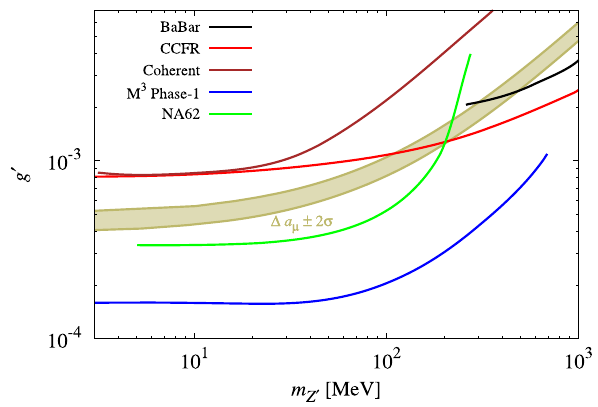
Fig. 3 The colored band represents the regions of parameter space in which an L μ − L τ gauge boson can resolve the Δ a μ anomaly (within 2 σ ). Constraints from BaBar [53], CCFR [54,55], Neutrino Nucleus Coherent elastic scattering [56], M 3 phase-I [57] and NA62 [58] exper- iments are shown by solid colored as